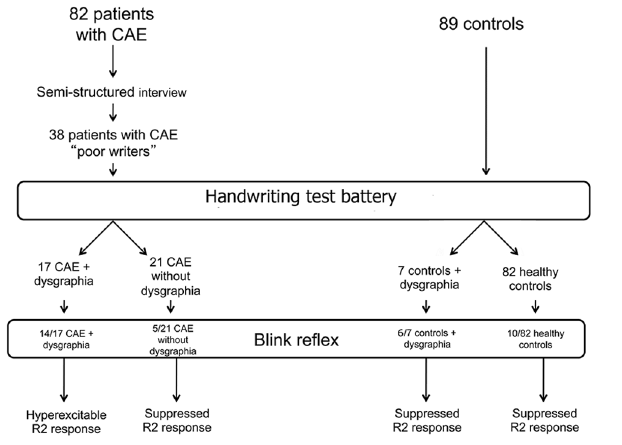
Fig 1. Diagram of the